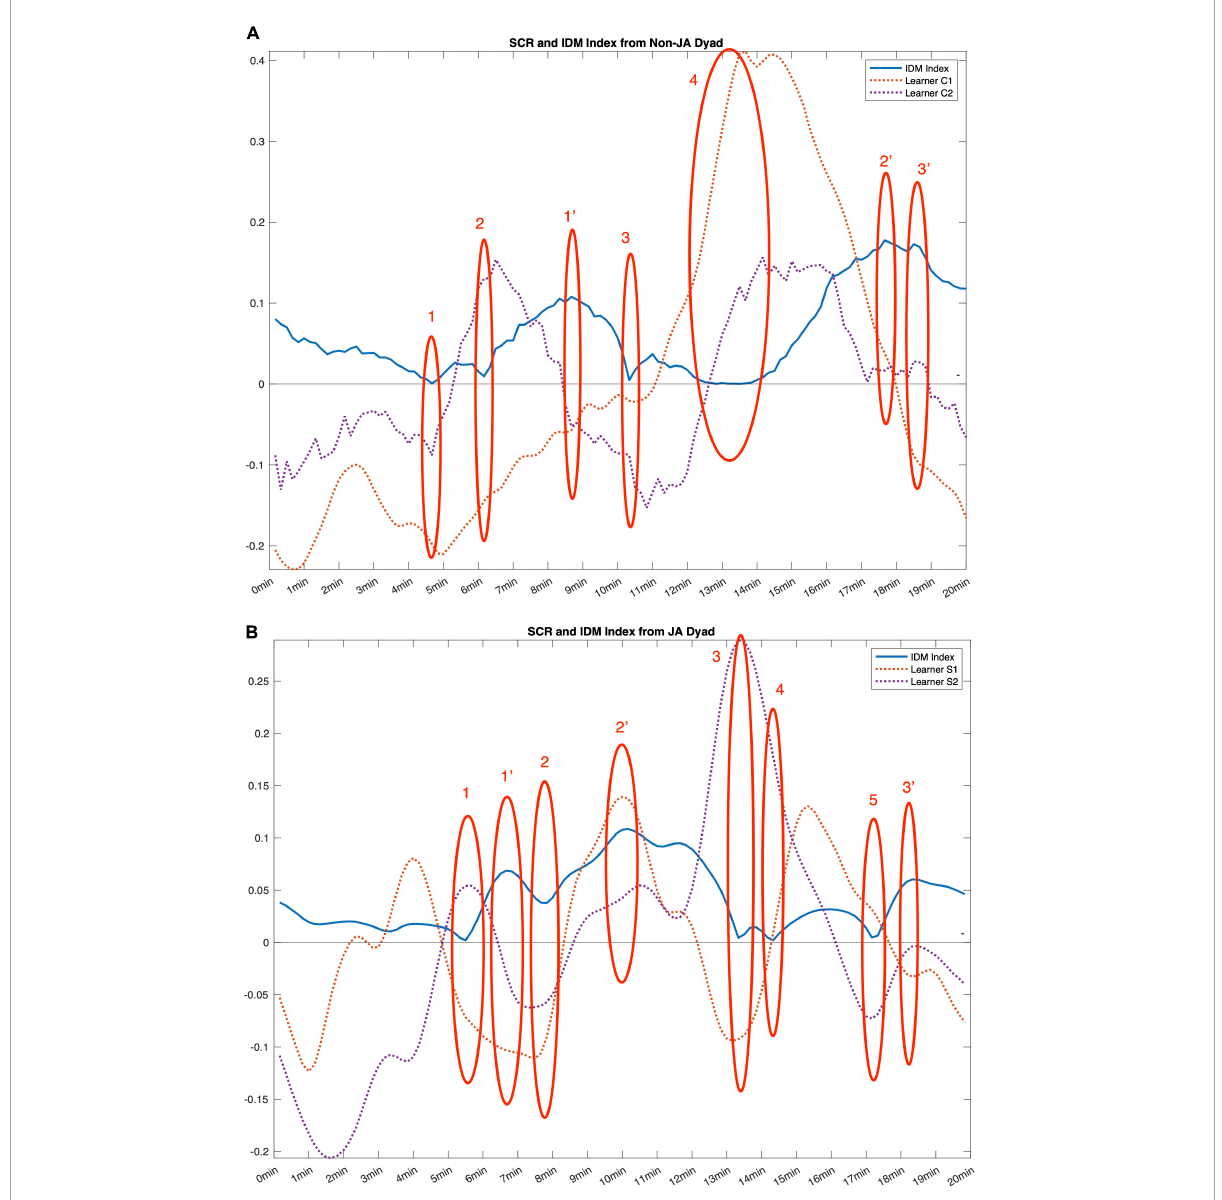
FIGURE3 Plots of IDM index of the non-JA treatment (A) and JA treatment (B) . Selected critical events in two collaborative learning sessions are marked in circles with